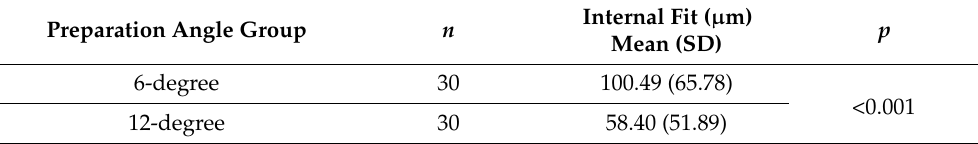
Table 2. Internal fit according to the preparation angle. SD: standard